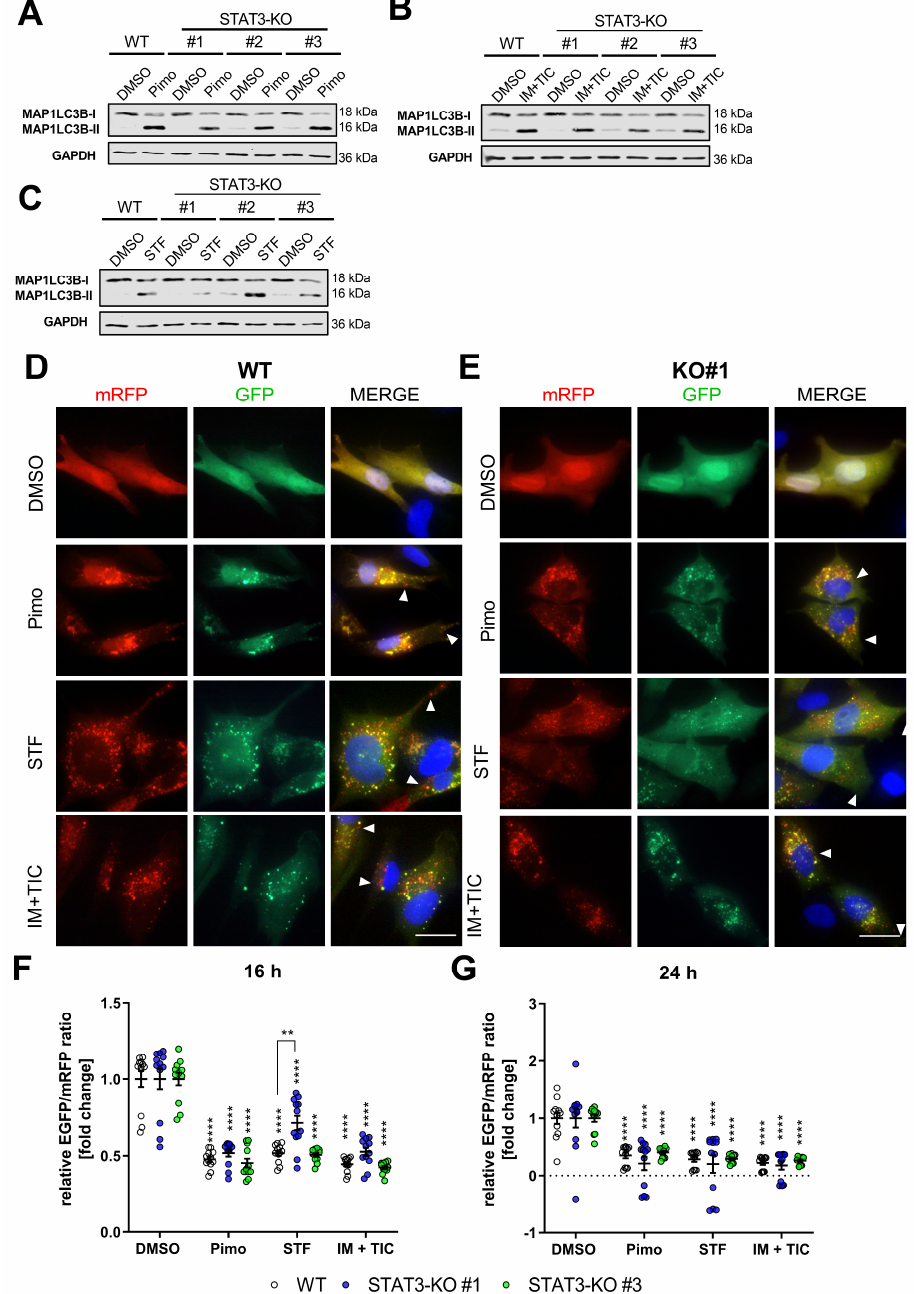
Figure 2. Depletion of STAT3 does not affect autophagy induction or autophagic flux. ( A – C ) Representative Western Blots of MAP1LC3B-I and II of MZ-54 WT cells and STAT3-KO-cells after treatment with ( A ) 12.5 µ M Pimozide (Pimo), ( B ) 20 µ M imipramine (IM) and 100 µ M ticlopidine (TIC) and ( C ) 40 µ M STF-62247 (STF) for 6 h. GAPDH served as a housekeeping protein. ( D , E )